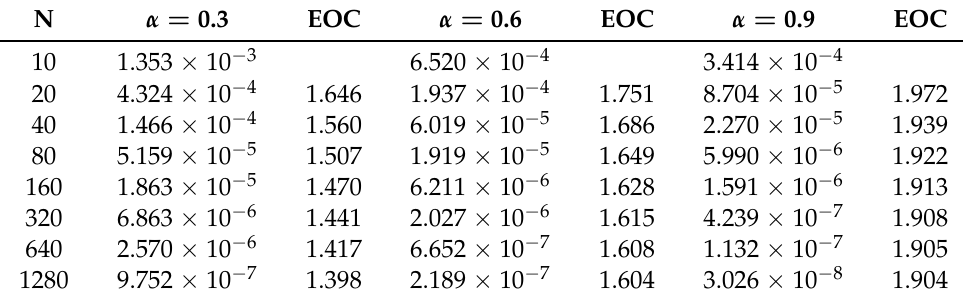
Table 6. Table showing the maximum absolute error and EOC for solving Example 3 using the predictor–corrector method for α < 1.